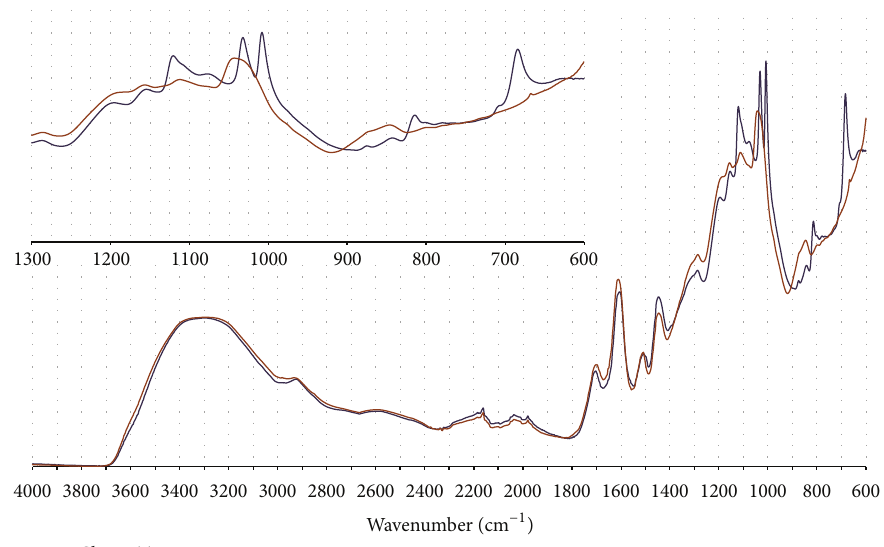
Figure 4: ATR FT-IR spectra of classic (blue) and formaldehyde-free (brown) tannin based rigid